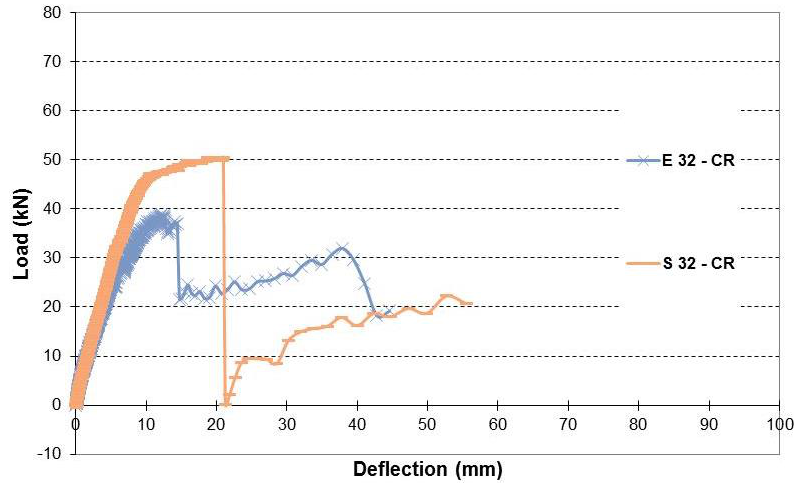
Figure 20. Load-deflection of beams with 32% corrosion levels (Repaired).